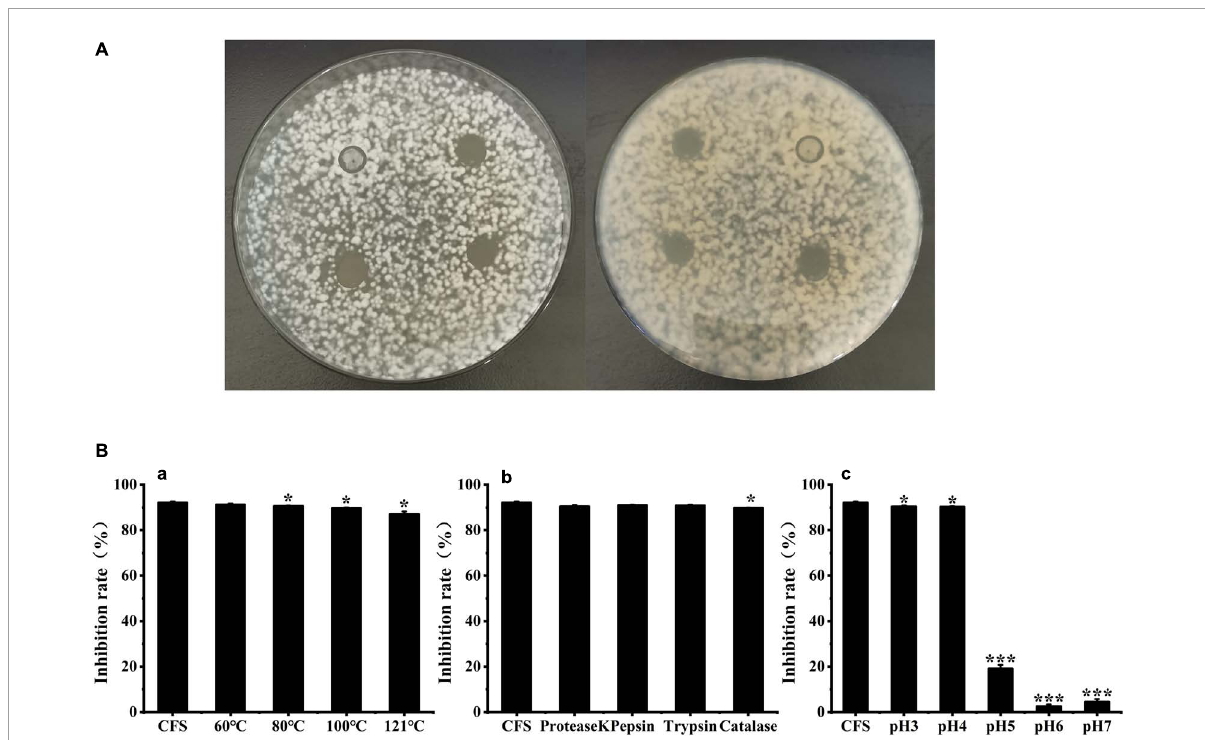
FIGURE2 Effects of Weissella cibaria BYL4.2-CFS on the antifungal activity of Penicillium chrysogenum . Antifungal activity of BYL4.2-CFS in agar diffusion assay (the front and back) (A) . Antifungal effect after heat treatment (a) , acid treatment (b) and protease action (c) , and untreated W. cibaria BYL4.2-CFS as a control (B) . Data are means ± SDs; * p ≤ 0.05 and *** p ≤